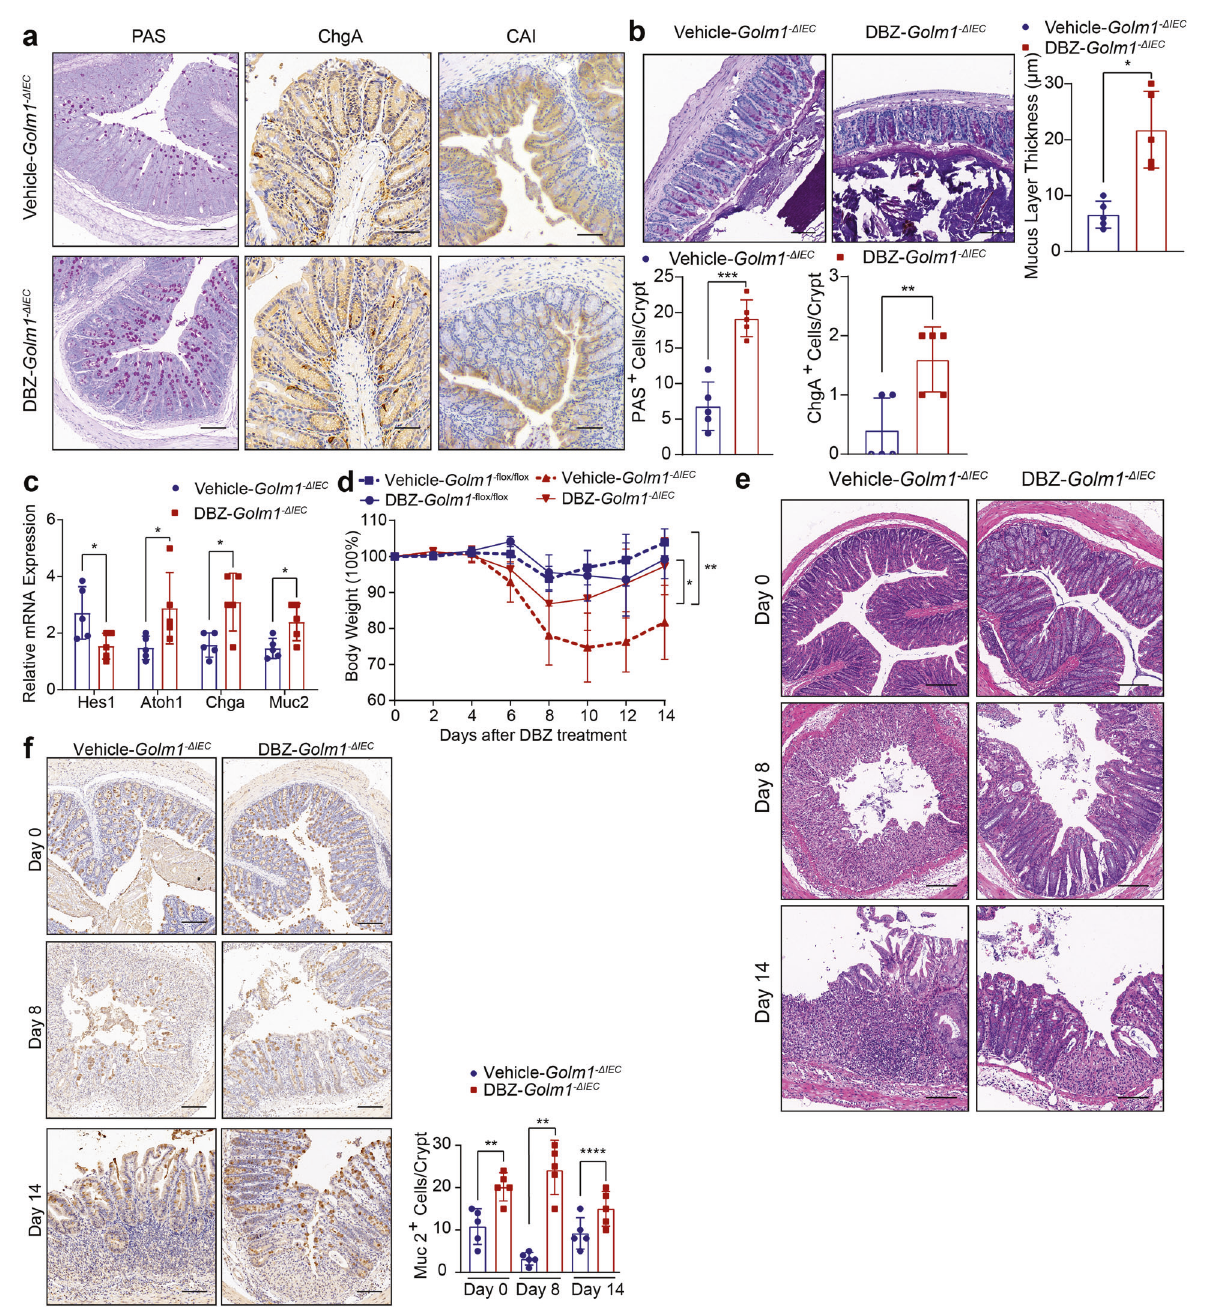
Fig. 7 Notch inhibitor-DBZ treatment reduces DSS-induced colitis in Golm1 − Δ IEC mice. a Representative PAS, ChgA and CAI staining of mouse colon tissues obtained from Golm1 − Δ IEC mice injected intraperitoneally with 3 μ mol/kg DBZ or vehicle for 5 days. Scale bars, 100 μ m. Quanti fi cations of PAS and ChgA staining are shown in the histogram (the data are represented as the means ± SEM, n = 5; ** P < 0.01, *** P < 0.001; unpaired, two-tailed Student ’ s t test). b Representative PAS staining of mouse colon sections fi xed by Carnoy ’ s fl uid from Golm1 − Δ IEC mice injected intraperitoneally with 3 μ mol/kg DBZ or vehicle for 5 days. Scale bars, 50 μ m. Quanti fi cation is shown in the histogram (the data are represented as the means ± SEM, n = 5; ** P < 0.01; unpaired, two-tailed Student ’ s t test). c The relative mRNA expression levels of the indicated genes in the distal colon of mice determined by qRT-PCR after DBZ/vehicle treatment. The relative expression re fl ects the fold change calculated by comparing with the expression levels in untreated Golm1 − Δ IEC mice (the data are represented as the means ± SEM, n = 5; * P < 0.05; unpaired, two-tailed Student ’ s t test). d The body weights of Golm1 − fl ox/ fl ox and Golm1 − Δ IEC mice treated with 2% DSS followed by DBZ administration were recorded on indicated days (the data are represented as the means ± SEM, n = 5; * P < 0.05, ** P < 0.01). e Representative H&E staining of mouse colon sections obtained from DBZ/vehicle-DSS-treated Golm1 − Δ IEC mice sacri fi ced on indicated days. Scale bars, 100 μ m. f . Representative MUC-2 staining of mouse colon sections obtained from Golm1 − Δ IEC mice treated with 2% DSS plus DBZ and sacri fi ced on indicated days. Scale bars, 100 μ m. Quanti fi cation is shown in the histogram (the data are represented as the means ± SEM, n = 5; ** P < 0.01, *** P < 0.001; unpaired, two-tailed Student ’ s t